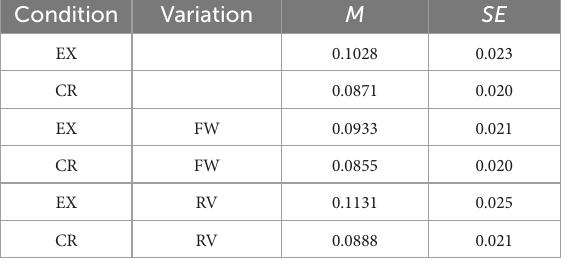
TABLE 5 Esteemed marginal means ( M) and standard error ( SE ) for EX (experimental) and CR (control) rebus resolution (RR), as well as for EX and CR conditions in FW (forward) and RV (reverse) variations of Experiment